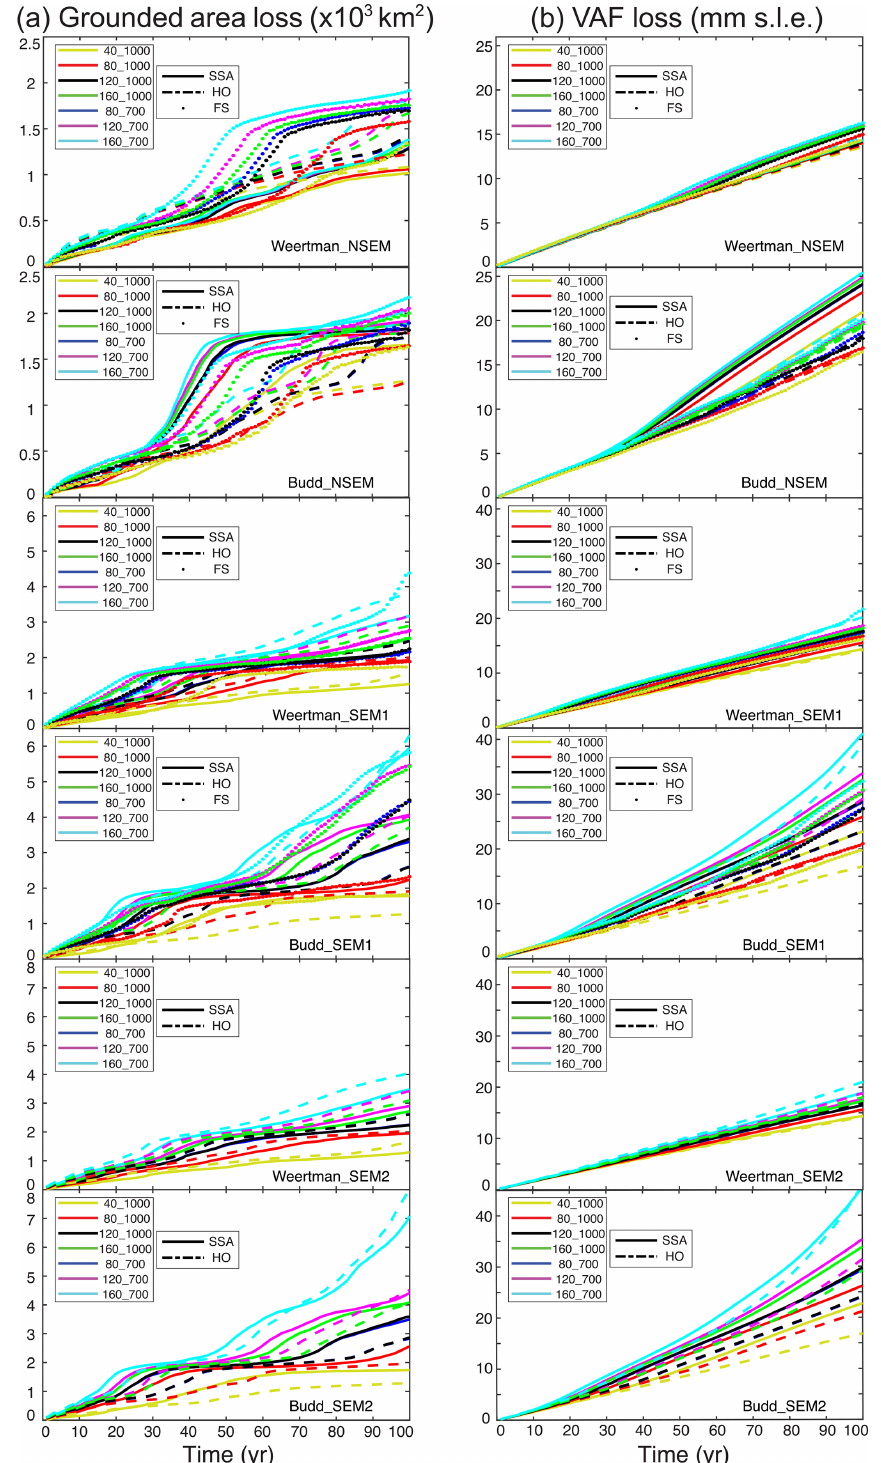
Figure 5. Grounded area loss (a) and volume above floatation (VAF) loss (b) of Thwaites Glacier, West Antarctica, for the 112 experiments over the next 100